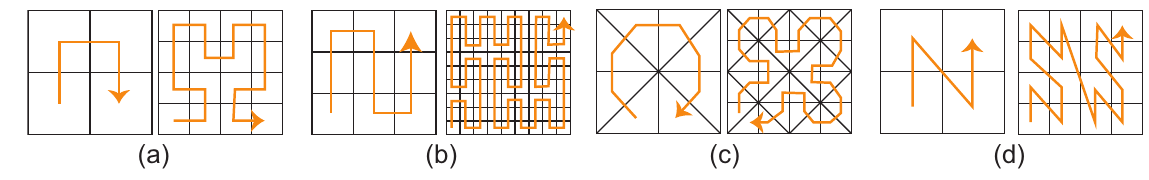
Figure 8. ( a ) Hilbert, ( b ) Peano, ( c ) Sierpinski and ( d ) Morton space filling